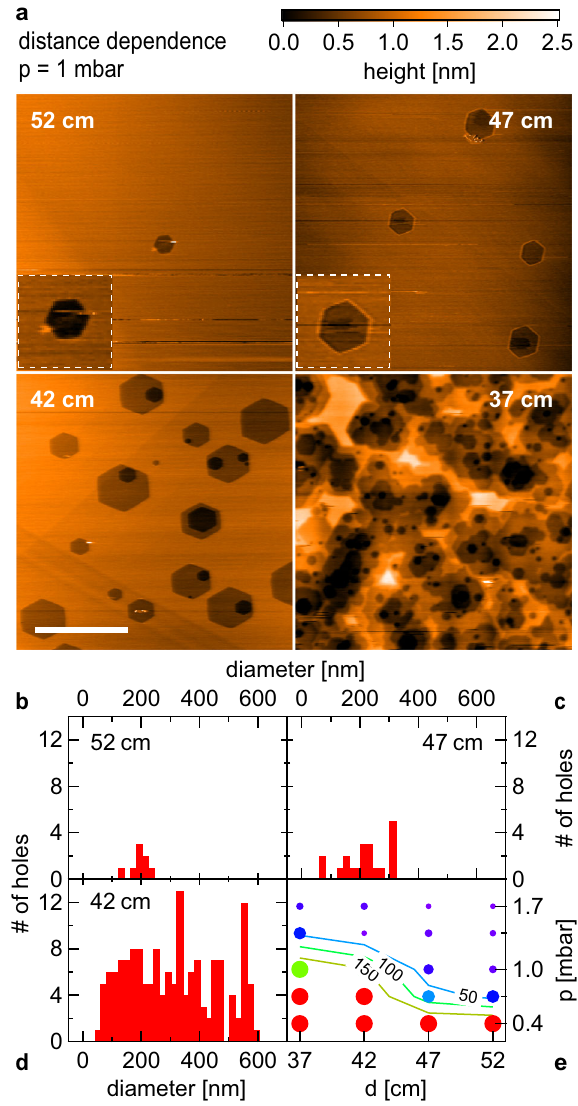
Fig. 1 Distance dependence of graphite exposures. a AFM images (tapping mode) of graphite surfaces for various distances d , as labeled, all exposed to the plasma for 1 h at p = 1 mbar and T = 400 °C, all shown on the same color scale. Main panels are 3 × 3 μ m 2 , scale bar is 1 μ m, insets ( dashed white boxes ) are 0.25 × 0.25 μ m 2 . Slight hexagon distortion at 42 cm is an imaging artefact due to drift. See supplementary online material for the complete distance and pressure matrix. b – d Histograms obtained from 10 × 10 μ m 2 scans, showing the number of holes against hole diameter (bin size 20 nm). e The size of the circle markers corresponds to the width of the diameter distribution. The color indicates the number of holes, with red corresponding to large number of holes. For samples located within the glowing plasma ( red circles ), a lower bound of 300 holes and a minimum width of distribution of diameter of 600 nm is